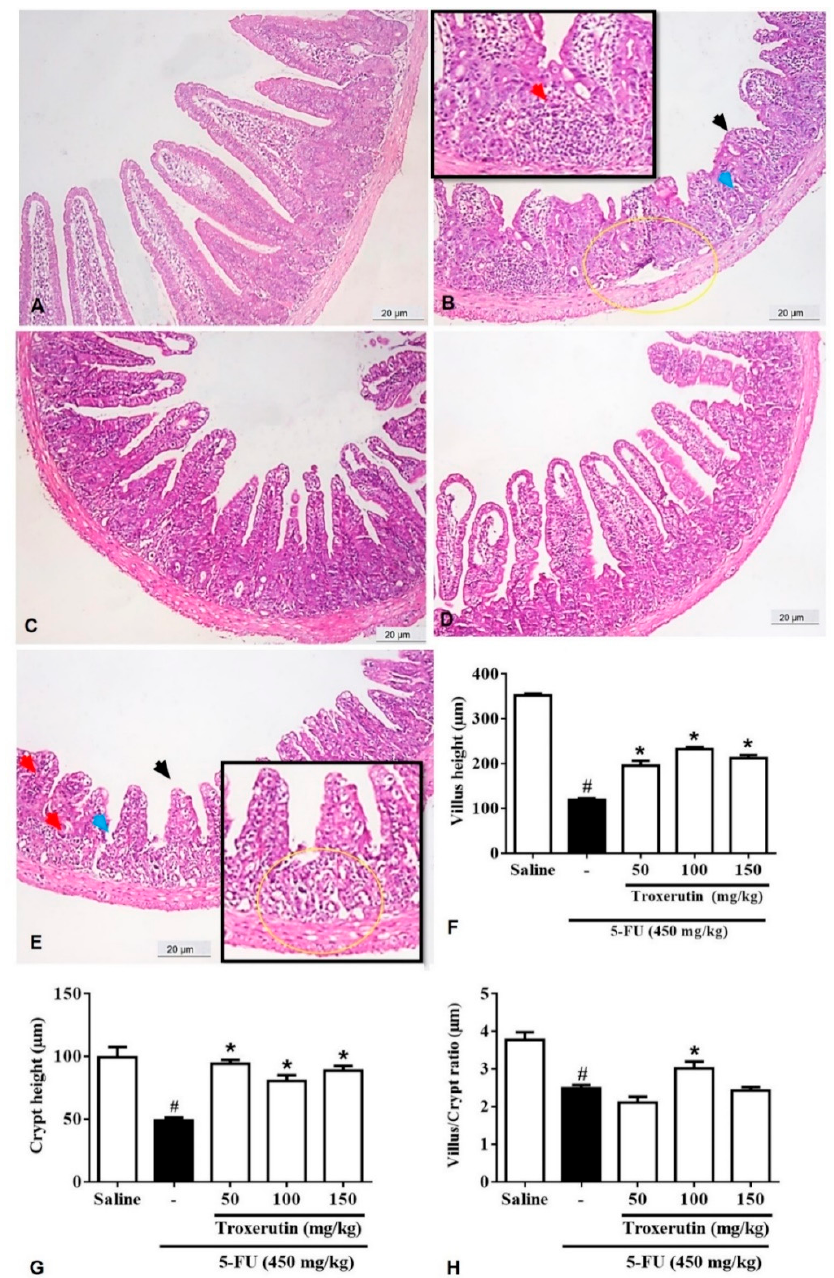
Figure 3. Histopathological analysis of duodenum. ( A ) Saline; ( B ) 5-FU; ( C ) TRX-50; ( D ) TRX-100; ( E ) TRX-150. 5-FU induced inflammatory cell infiltrate (red arrow), decreased intestinal villi (black arrow), loss of intestinal crypt architecture (blue arrow), edema (yellow circle). Pretreatment with TRX (50, 100 and 150 mg/kg) decreased the inflammatory infiltrate and prevented the shortening of the villi ( F ), increased crypt depth ( G ) and decreased villus/crypt ratio ( H ), with greater reversion of the 5-FU effect in the TRX 100 + 5-FU group. Values were expressed as mean ± SEM. One-way ANOVA followed by the Tukey’s test were used for the statistical analysis was used, where # p < 0.05 vs saline group and * p < 0.05 vs group 5-FU.